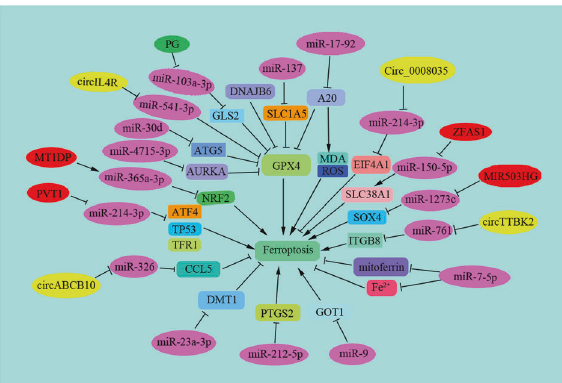
Fig. 3 Ferroptosis is regulated by ncRNAs. Ferroptosis is regulated by noncoding RNAs including lncRNAs, circRNAs and miRNAs. The key targeting proteins are